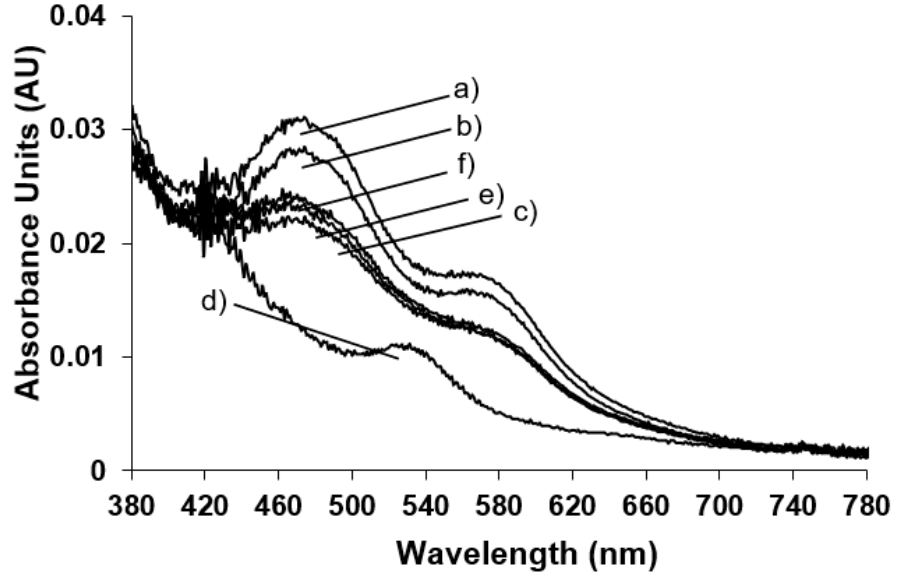
Figure 3. Room temperature UV-Vis spectra of ( a ) native NDO; ( b ) in the presence of O 2 -saturated naphthalene (160 µ M); ( c ) the same sample reported in ( b ) reduced by the addition of sodium dithionite (1.25 mM), t0 min; ( d ) t5 min; ( e ) t10 min; and ( f ) t15 min.